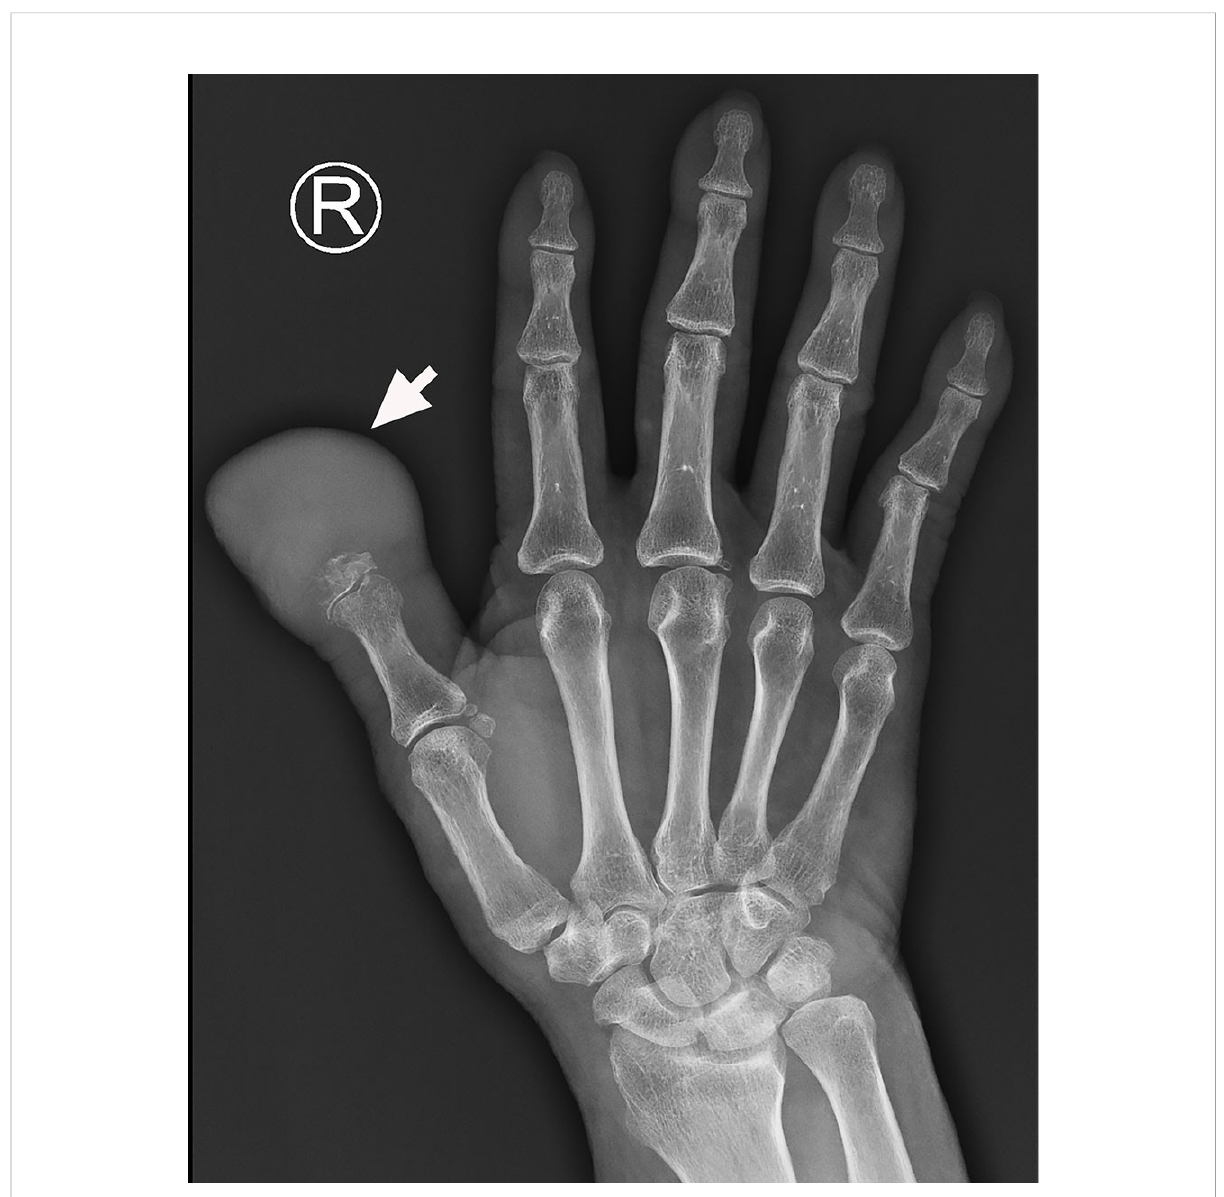
FIGURE 1 The X-ray image shows a mass at the distal end of the right thumb with marked phalanx destruction